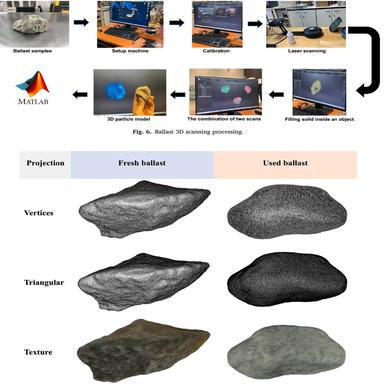
3D particle was obtained by scanning for fresh and used ballast particles.